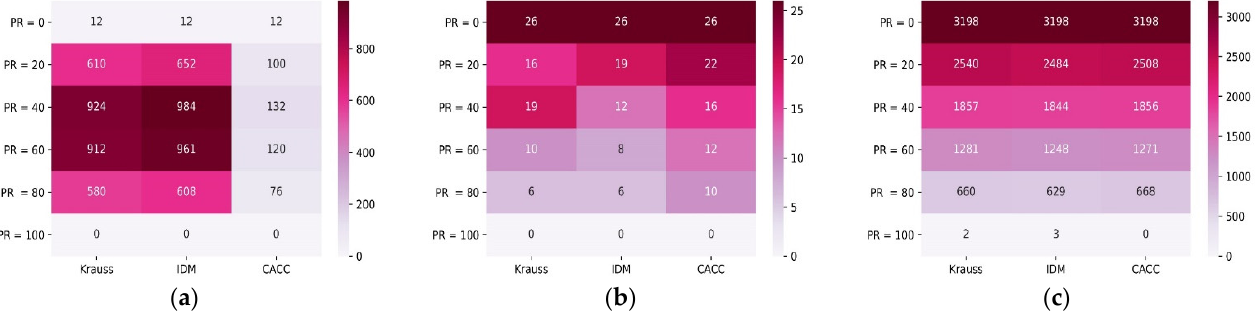
Figure 6. Number of conflicts based on different conflict types: ( a ) lead/follow conflicts; ( b ) merging conflicts; ( c ) crossing conflicts.